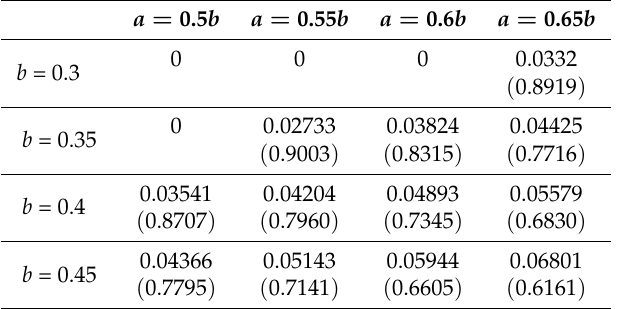
Table 1. The changes of the negative index band when inner radius and outer radius vary. In each cell, the upper and lower numbers denote the band width and center frequency,